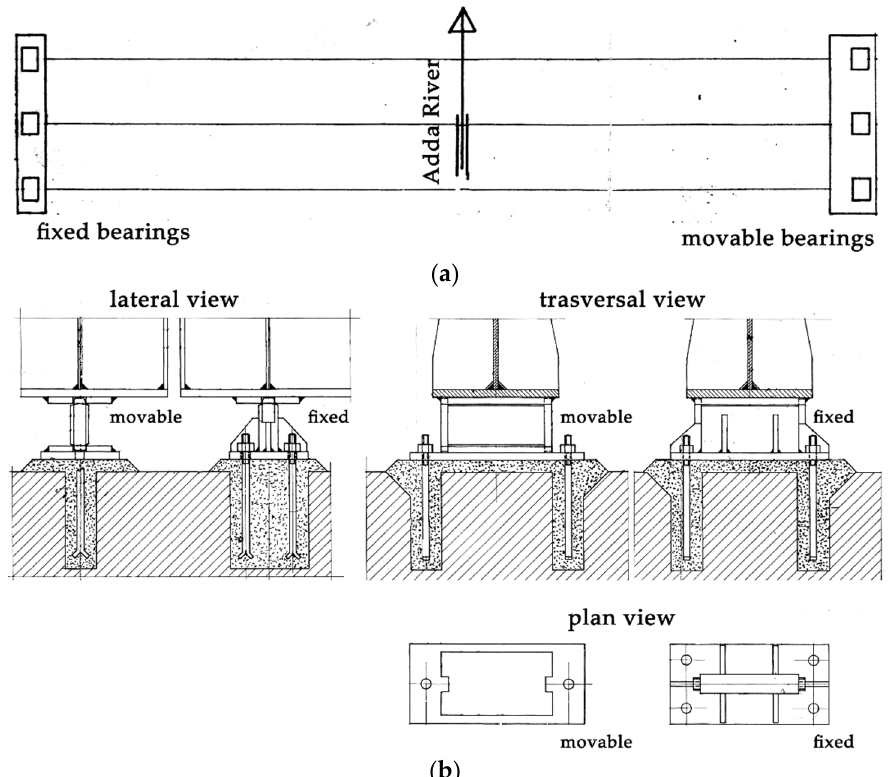
Figure 7. Bridge support devices: ( a ) kinematics of the bearings, with knuckle pin bearing (left) and sliding roller bearing (right); ( b ) lateral, front, and plan view of the bearings.